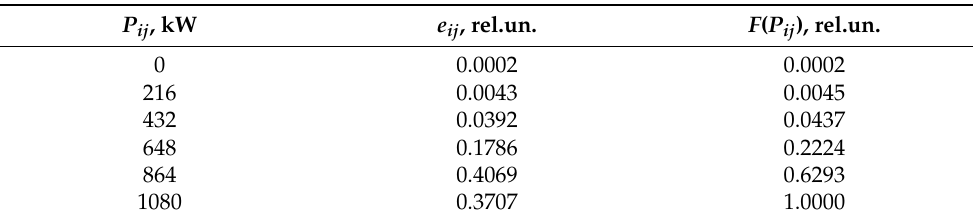
Table 14. Static series of the probability distribution of ordinates of the initial group ELC with the use of frequency control.